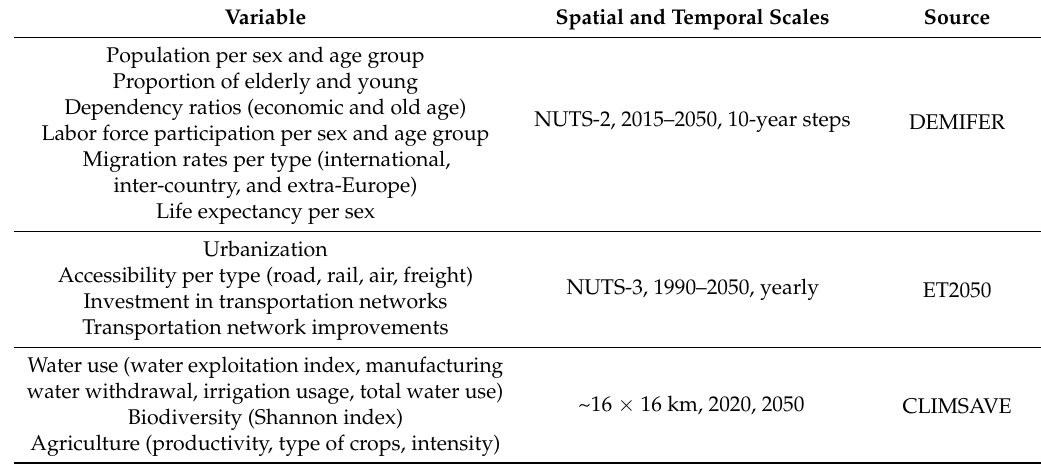
Table 3. Quantitative projections of relevant variables related to human vulnerability that are readily available through the scenario matching approach for the three Ext-SSPs. All these projections cover the 28 member countries of the European